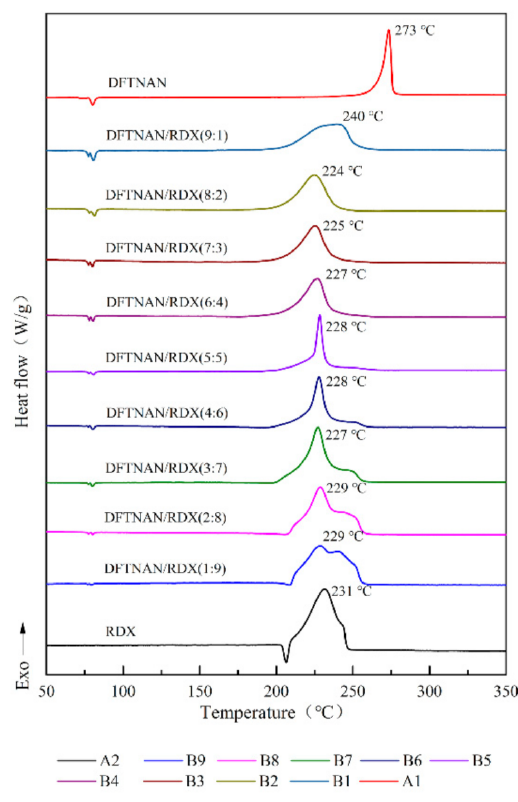
Figure 5. DSC curves of DFTNAN, RDX and mixtures with different ratios.